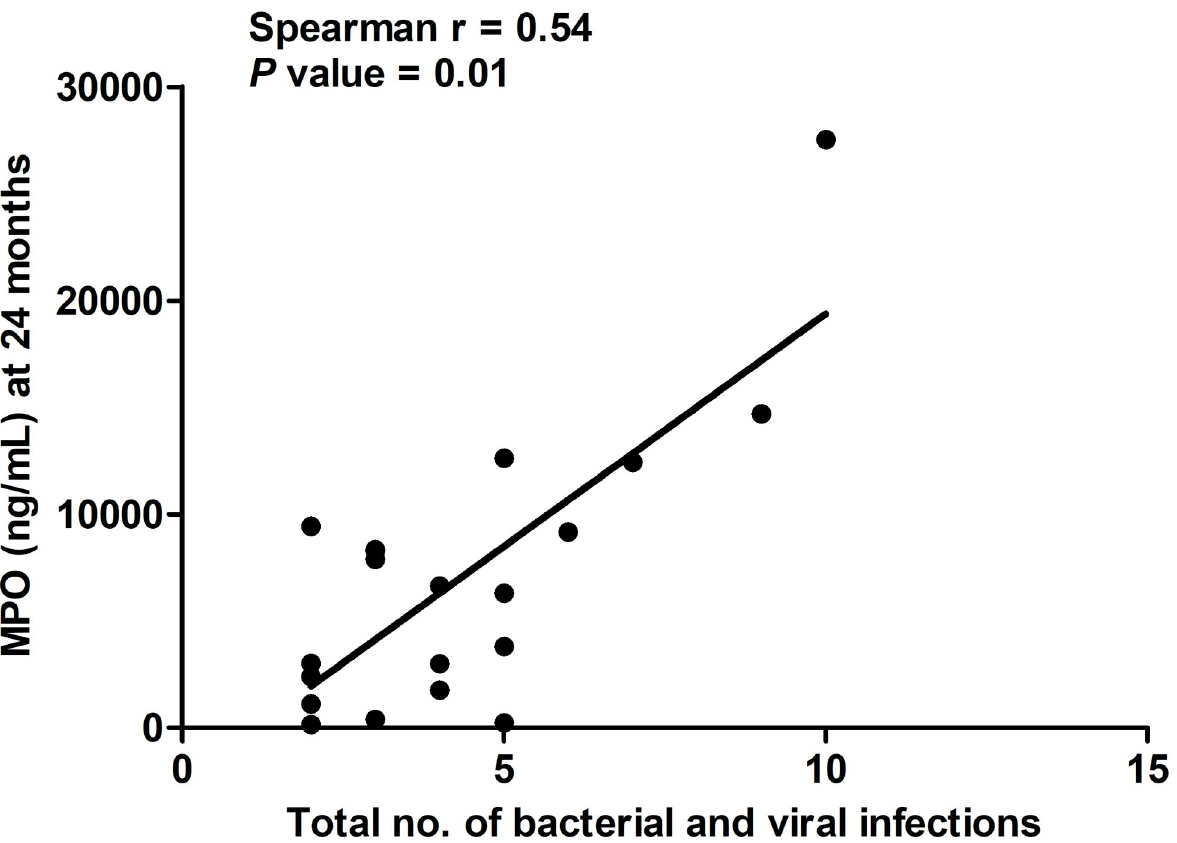
Fig 2. Correlation of the total number of bacterial and viral infections (n = 20) with fecal MPO levels at 24 months. The X-axis indicates the total number of bacterial and viral infections, while the Y-axis denotes fecal MPO levels (ng/mL) at 24 months of age. We performed the Spearman correlation test for statistical evaluation (r = 0.54 and P =